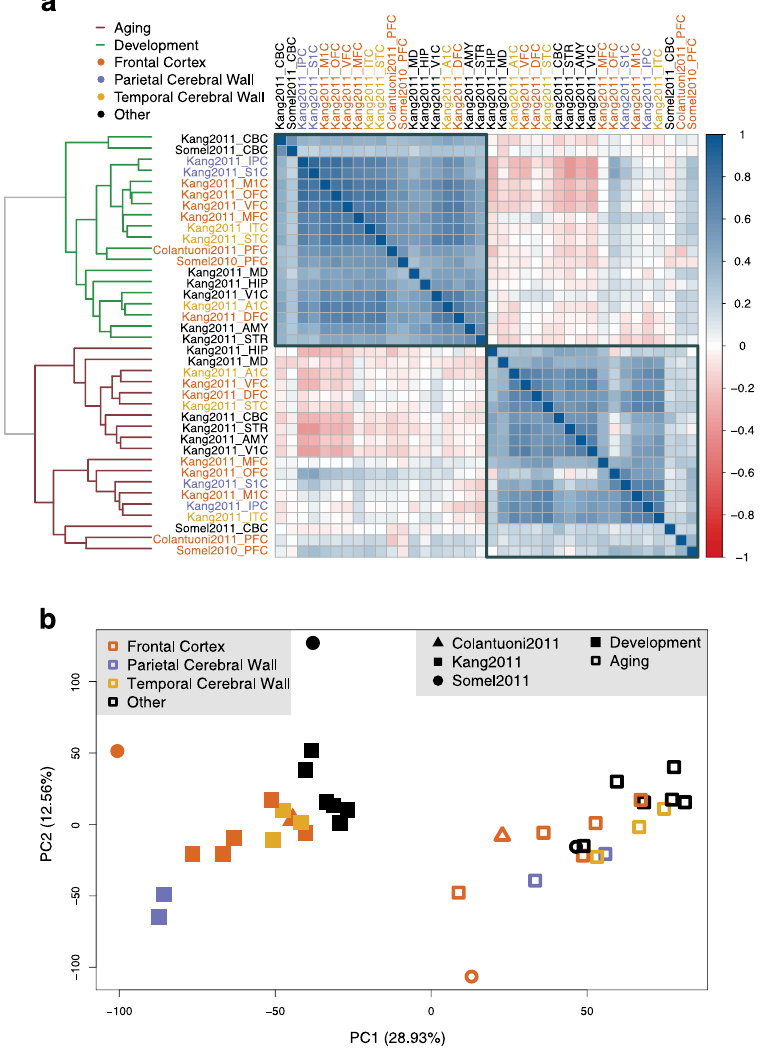
Figure 1. Expression changes during brain postnatal development and aging. ( a ) Correlations among expression-age correlation coefficients (in development or in aging) across subdatasets. The color of the squares changes with the magnitude of the Spearman correlation coefficient between pairs of subdatasets (across 11,563–22,713 common genes in each pairwise comparison); darker colors show stronger negative (red) or positive (blue) correlation. Row and column labels indicate the brain region and the edge color of the dendrogram shows the time period of datasets. The order of brain regions is determined by agglomerative hierarchical clustering using the Spearman correlation coefficients between datasets based on the age-related expression changes. ( b ) Principle components analysis of age-related expression change in brain regions. The analysis was conducted on an age-expression Spearman correlation coefficient matrix of 11,258 genes and 38 subdatasets. The x- and y-axes show the first and second principle components. The values in the parentheses show the variation explained by each